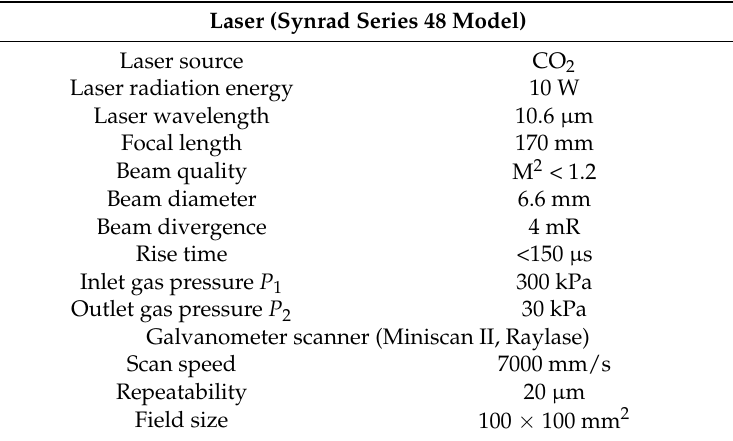
Table 2. Experimental conditions for laser trepanning depth comparison.